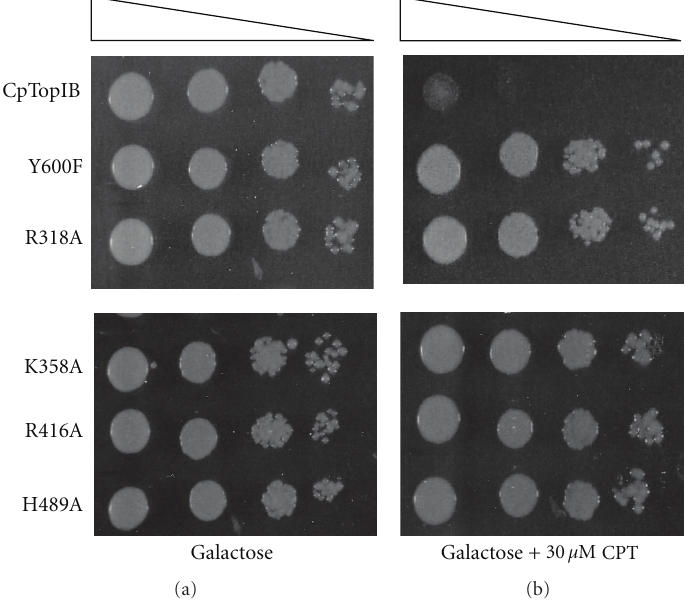
Figure 4: Expression of CpTopIB gene induces sensitivity to CPT-resistant yeast strain MBY3 ( rad52 Δ ). Exponentially growing cells in dextrose, transformed with vectors carrying the cryptosporidial wild type and point mutations driven by GAL1 promoter, were serially 10-fold diluted starting from OD 595 = 0.5. Five microliters were spotted on selective media under induced (2% galactose) conditions in the presence or absence of 30 μ M CPT. All plates contained 0.375% DMSO. Empty assay was performed under similar assay conditions but expression the YCpGAL(leu-) vector without any insert.